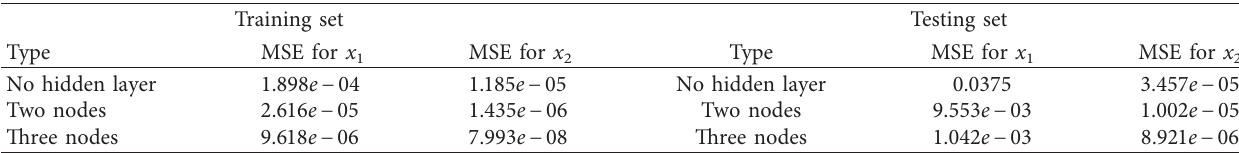
Figure 8: Identification results of dynamic neural network with three nodes in the hidden layer: (a) result for outlet sulphur dioxide concentration; (b) result for the pH value in slurry. Table 2: Identification results in training and testing